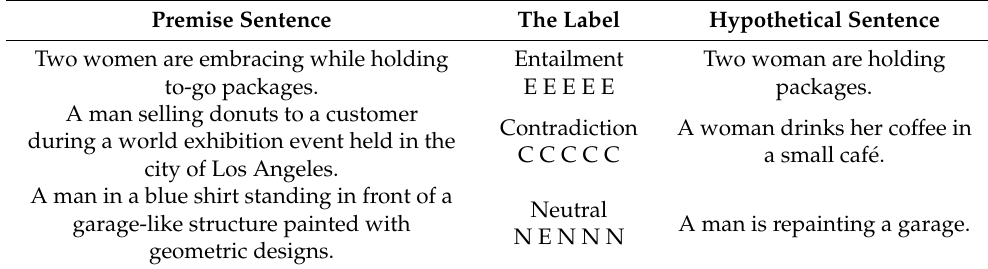
Table 1. Sample data of SNLI dataset.